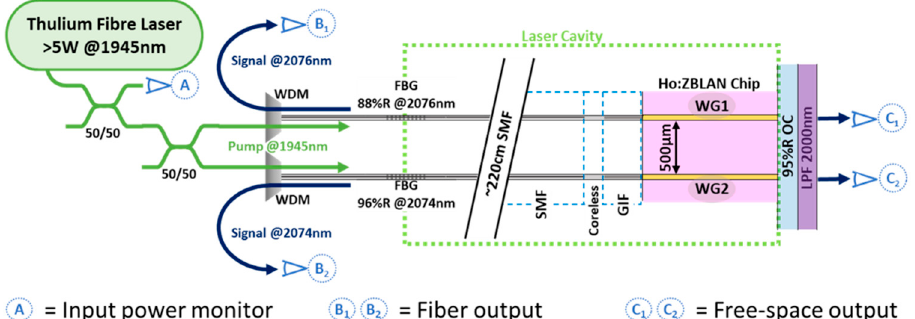
Figure 1. Schematic overview of the laser design. The laser cavity is pumped by a thulium fiber laser and comprises an fiber Bragg grating (FBG) output-coupling mirror, a GIF-tip (SMF/Coreless/GIF sections, described in text), the waveguides (WGs) embedded in the holmium-doped zirconium glass (Ho:ZBLAN) substrate, and a partially reflective bulk resonator mirror. Pump power is monitored at A, counter-propagating signal light as a fiber output at positions B i . and forward-propagating signal light as free-space output after a 2000 nm long-pass filter (LPF) at positions C i . In this diagram channel 1 is displayed above channel 2. Table 1. Physical parameters associated with each laser channel.